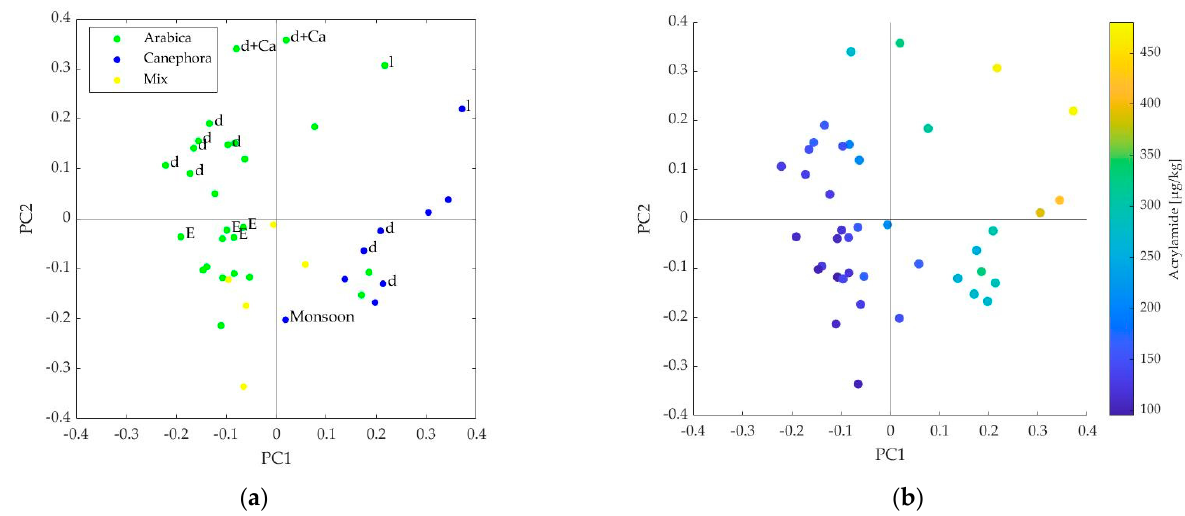
Figure 2. ( a ) Scores plot of principal components (PC) 1 and 2, 40 commercial coffee samples are marked with their known attributes: l=light roasting degree, d= dark roasting degree, +Ca= additive cardamom in Turkish coffee; ( b ) scores plot of PC1 and PC2, 40 commercial coffee samples are marked with their measured content of acrylamide [µg/kg].